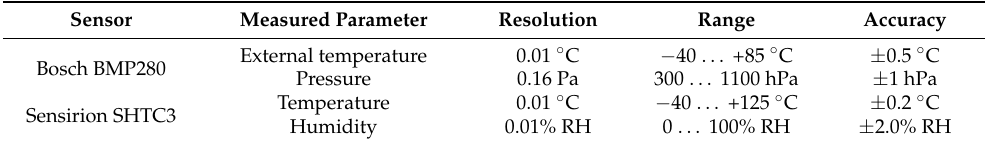
Table 1. Sensors parameter